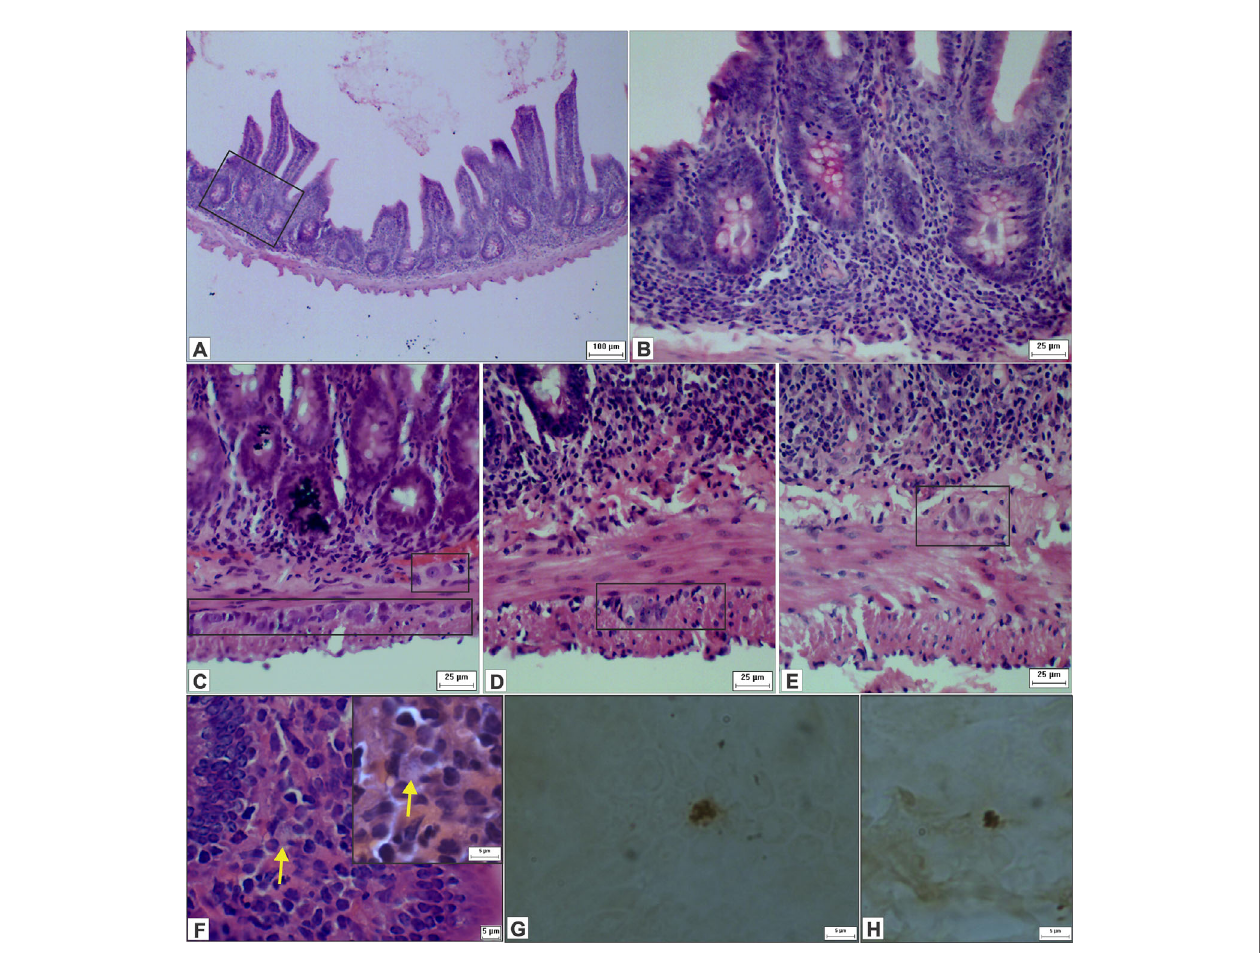
FIGURE 10 | Photomicrograph of cross-sections of the ileum of hamsters infected by L. (V.) braziliensis . (A) Presence of in fl ammatory in fi ltrates in the intestinal wall and in the crypts (HE staining, 10× magni fi cation, scale bar = 100 μm; Olympus CX31). (B) Higher magni fi cation of image A (HE staining, 40× magni fi cation, scale bar = 25 μm; Olympus CX31). (C – E) In fl ammatory cells within and close to the myenteric and submucosal ganglia, suggestive of ganglionitis and periganglionitis (HE staining, 40× magni fi cation, scale bar = 25 μm; Olympus CX31). (F) Suggestive amastigotes forms (arrow), presence of immune cells and IELs (HE staining, 100×